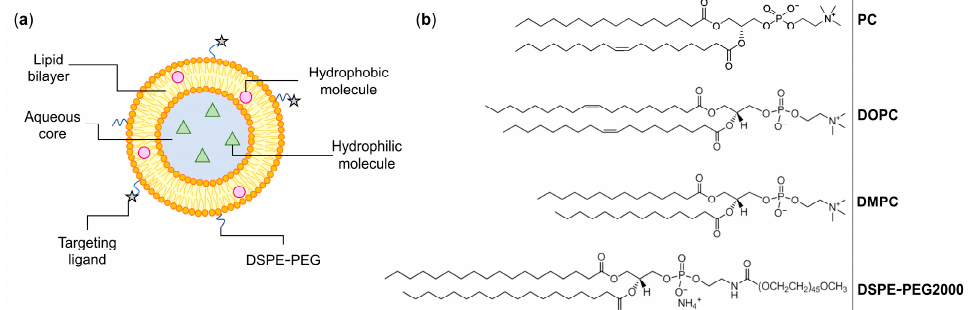
Figure 1. ( a ) Schematic representation of a liposome. These lipid-based nanosystems mimic biological membranes and are composed of one (unilamellar) or more (multilamellar) concentric lipid bilayers separated by aqueous compartments. Liposomes are able to accommodate both hydrophilic and hydrophobic molecules and their surface may be coated with specific ligands that recognize receptors overexpressed at tumor cells. ( b ) Chemical structures of commonly used phospholipids for the preparation of liposomes. PC: phosphatidyl choline; DOPC: dioleoyl phosphatidyl choline; DMPC: dimyristoyl phosphatidyl choline; DSPE-PEG: poly(ethylene glycol) 2000 covalently linked to distearoyl phosphatidyl ethanolamine. Images adapted from